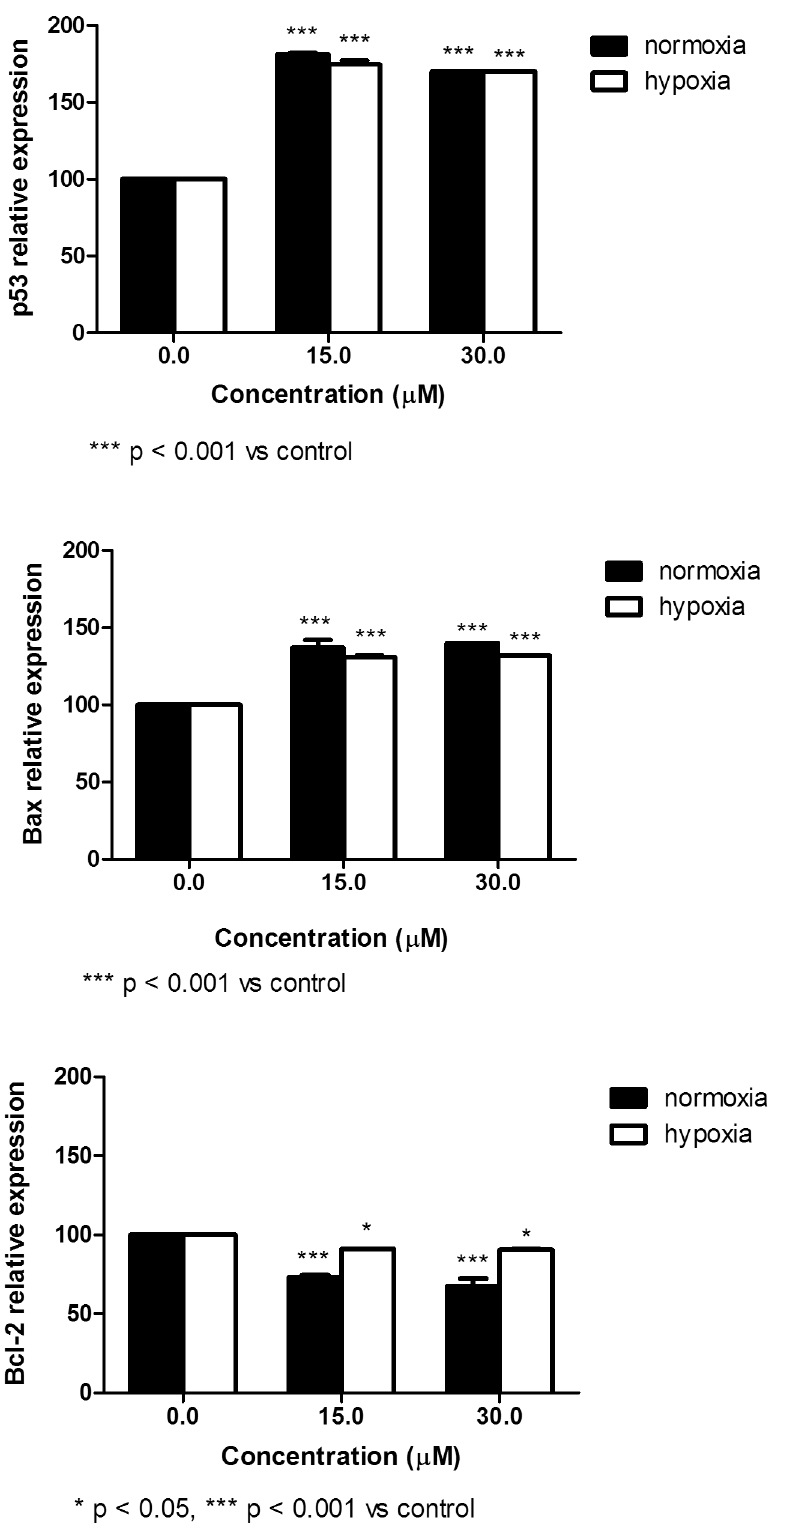
Figure 7. Effect of SR on p53, Bax and Bcl-2 protein expression determined in normoxic and hypoxic conditions on REH cells. Cells were treated with 0 to 30 m M SR for 24 h. Data are presented as mean 6 SEM of at least four different experiments.